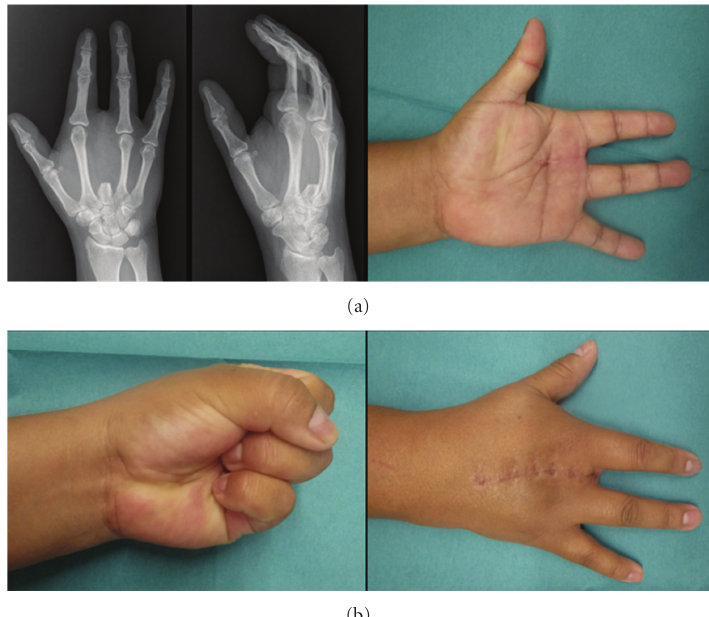
Figure 11: Eighteen-month postoperative clinical and radiological presentation demonstrating full range of motion without tumor recurrence.